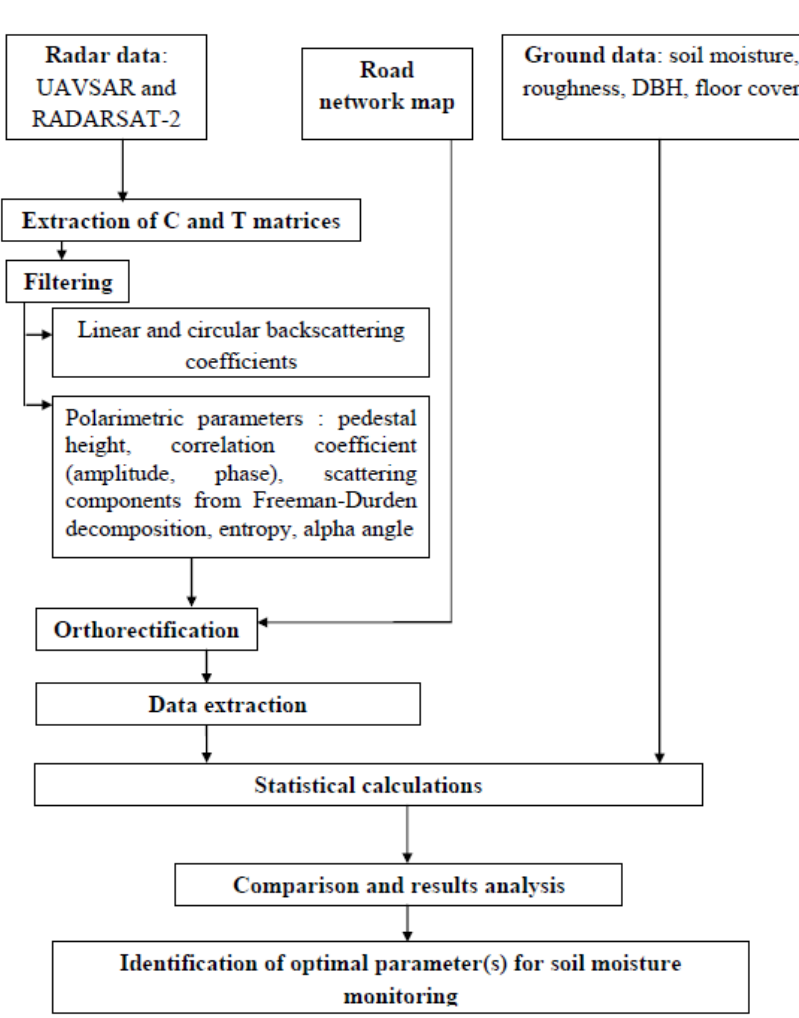
Figure 3. Schematic diagram of methodology.